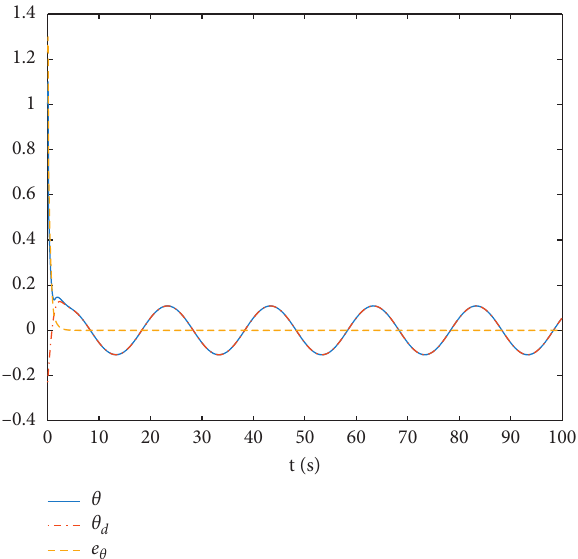
Figure 7: Trajectories of attitude θ , ideal position θ